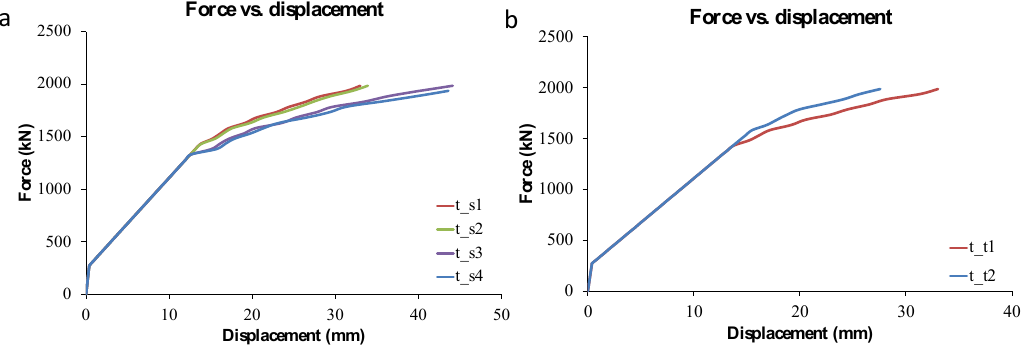
Figure 9. Influence on the force ‐ deflection response of the simulated model of the: (a) post ‐ cracking tensile capacity of SFRC (due to preferential fibre orientation profile); (b) pre ‐ stress level on steel and CFRP reinforcements.